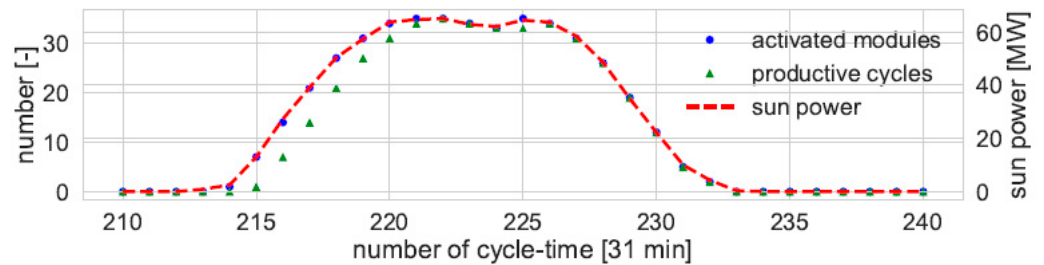
Figure 7. Solar power requirement for a single reactor and for a module ( left : nickel-ferrite, right : ceria).